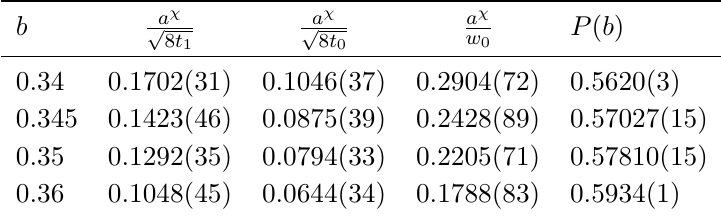
Table 6. Lattice spacing in units of √ 8 t 1 for the supersymmetric theory. For comparison with other authors we also convert to √ 8 t 0 and w 0 units using the conversion factor determined in the previous section table 3. The last column displays the plaquette expectation value extrapolated to the massless gluino